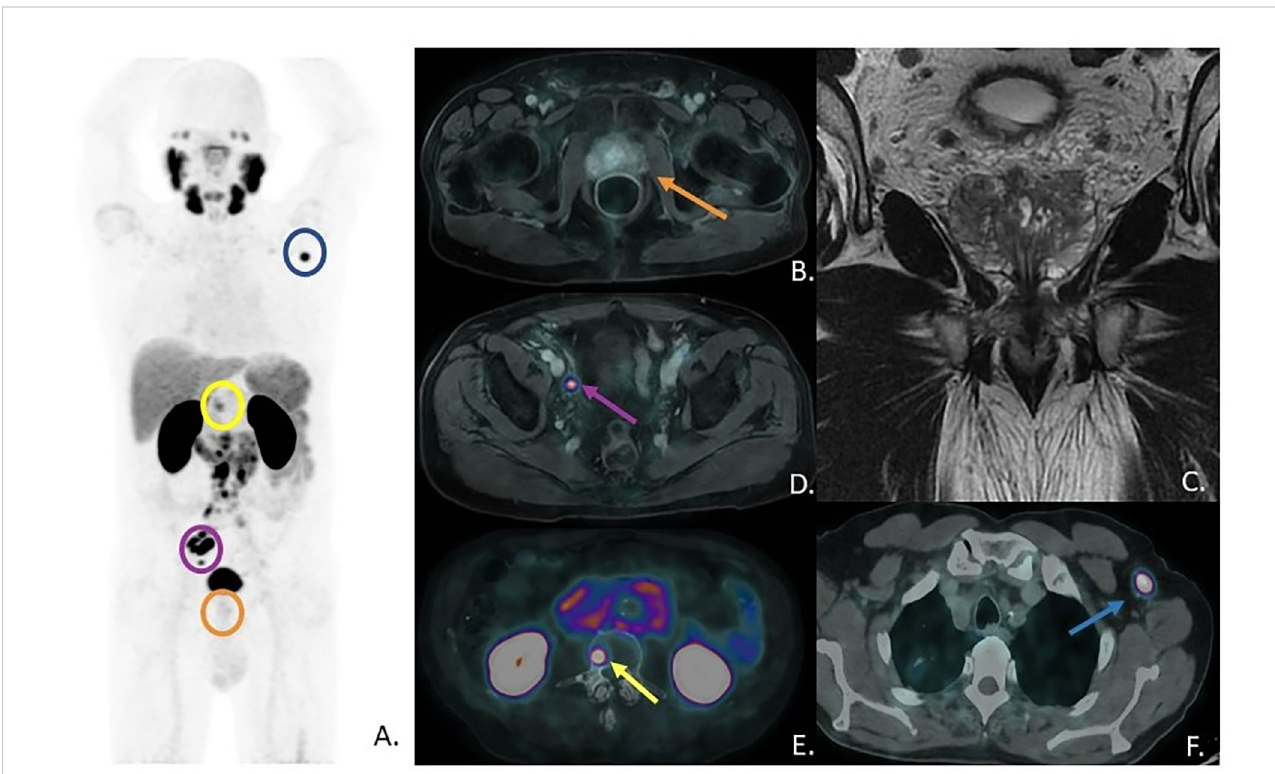
FIGURE 1 (A) [ 68 Ga]Ga-PSMA-11 PET Maximum-Intensity-Projection - MIP; (B) prostate gland at axial-PSMA-PET fused with previous mpMRI axial T1-Lava sequence; (C) prostate gland at mpMRI, coronal view, T2 sequence; (D) right external iliac lymph-node uptake at axial PSMA-PET fused with previous mpMRI; (E) bone lesion at L3 vertebral body with osteoblastic pattern and multiple lumbar-aortic lymph-nodes at axial fused PSMA-PET/CT; (F) left axillary lymph-node uptake at axial fused